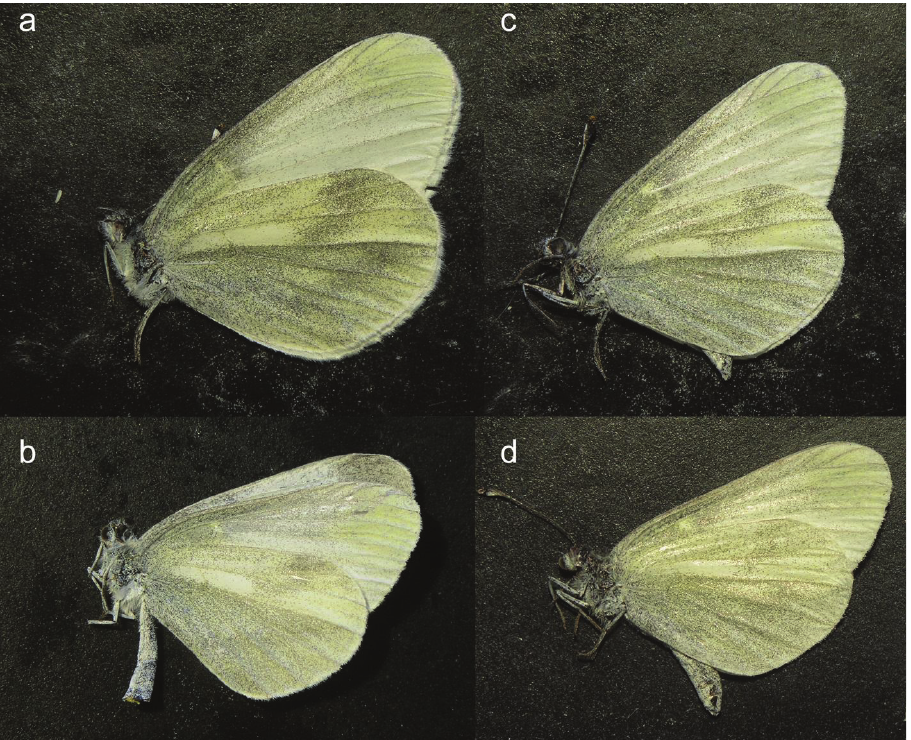
Figure 4. Males of Leptidea sinapis ( a specimen L1 b specimen L26) and Leptidea juvernica , ( c specimen L3 d specimen L8), with different scores of subjectively evaluated wing characters: the hind wing under- side suffusion below vein M3: 0 – lighter, with better expressed lighter spots between veins; 1 – stronger, with scarcely seen lighter spots; and the fore wing apex shape: 1 – more acute, 0 – more rounded. The scores for the shown specimens are as follows (suffusion, apex shape): a (0,0); b (1,0); c (1,1); d (1,0); a and c are variants most frequent in the respective